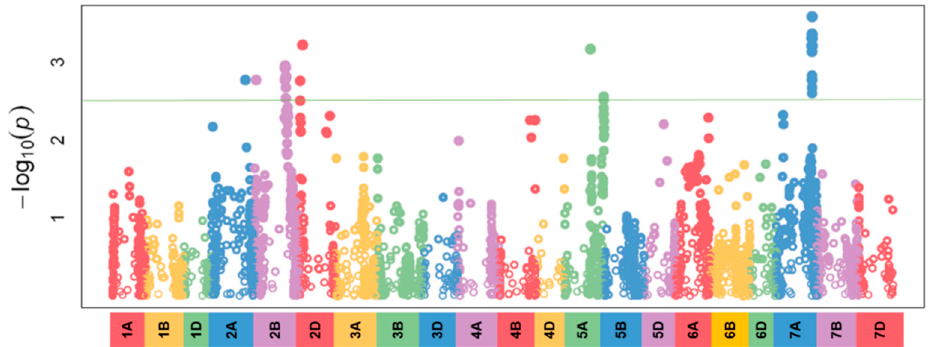
Figure 1. Manhattan plot, average infection values on the 21st day after inoculation under greenhouse conditions, according to the chromosomal localization of the markers (level of significance: -log 10 ( p ) 2,5; Martonvásár, 2007, 2009).